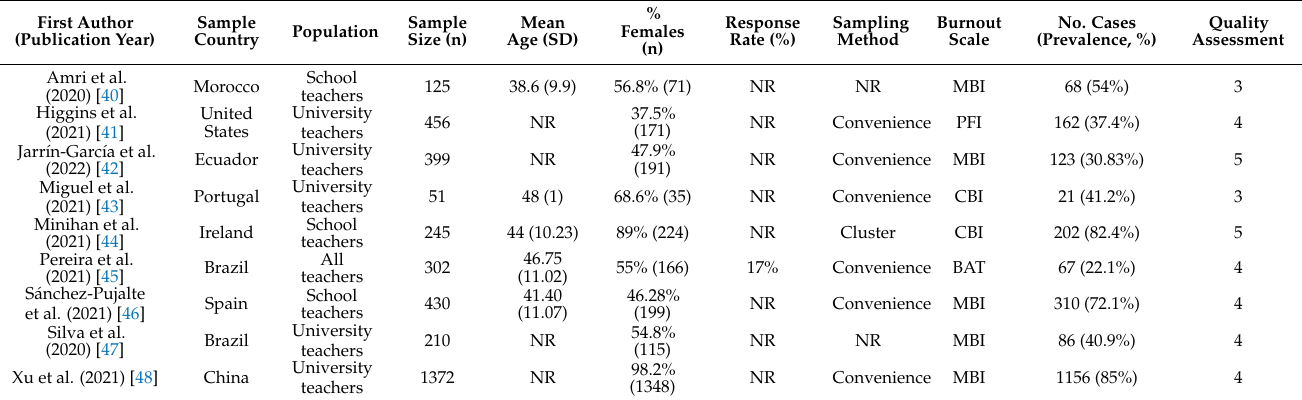
Table 1. Characteristics of the studies included in the meta-analysis.